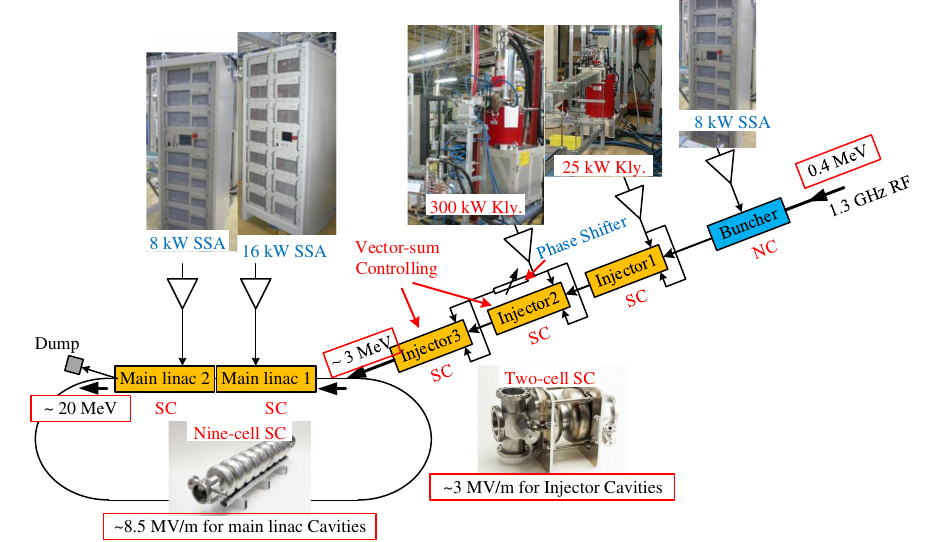
FIG. 1. Layout of the cERL. The cavities, rf source, and beam energy are presented in the figure. The marked values of the beam energy and electric field indicate the current state during beam commissioning.